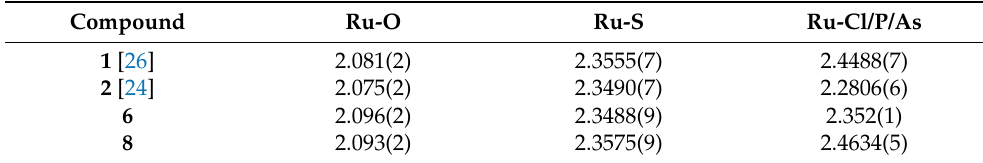
Table 1. Selected bond lengths in ruthenium–pyrithionato complexes